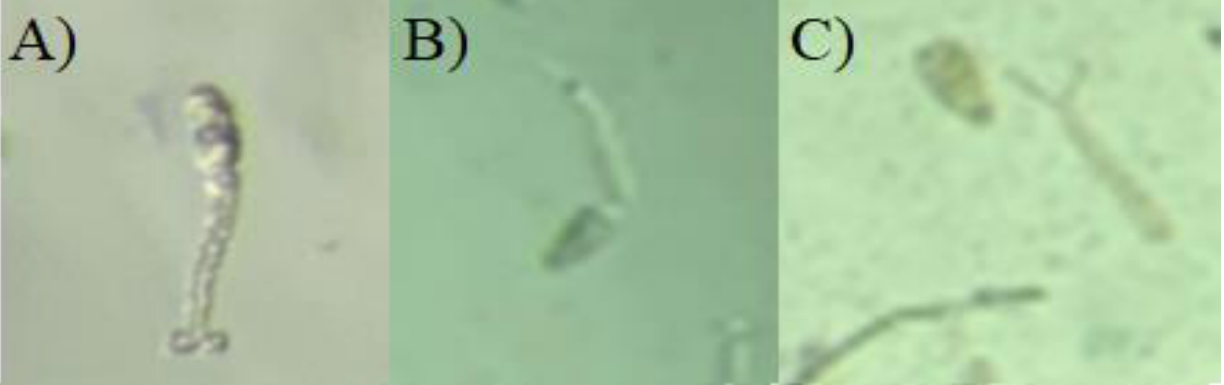
Figure 7. Cercariae of S. mansoni exposed to the fraction. Exposed to the negative control ( A ); to niclosamide : 1.0 μg/ mL ( B ) and to the fraction with tail and cercarial body separation ( C ). niclosamide: 1.0 µ g/mL ( B ) and to the fraction with tail and cercarial body separation ( C